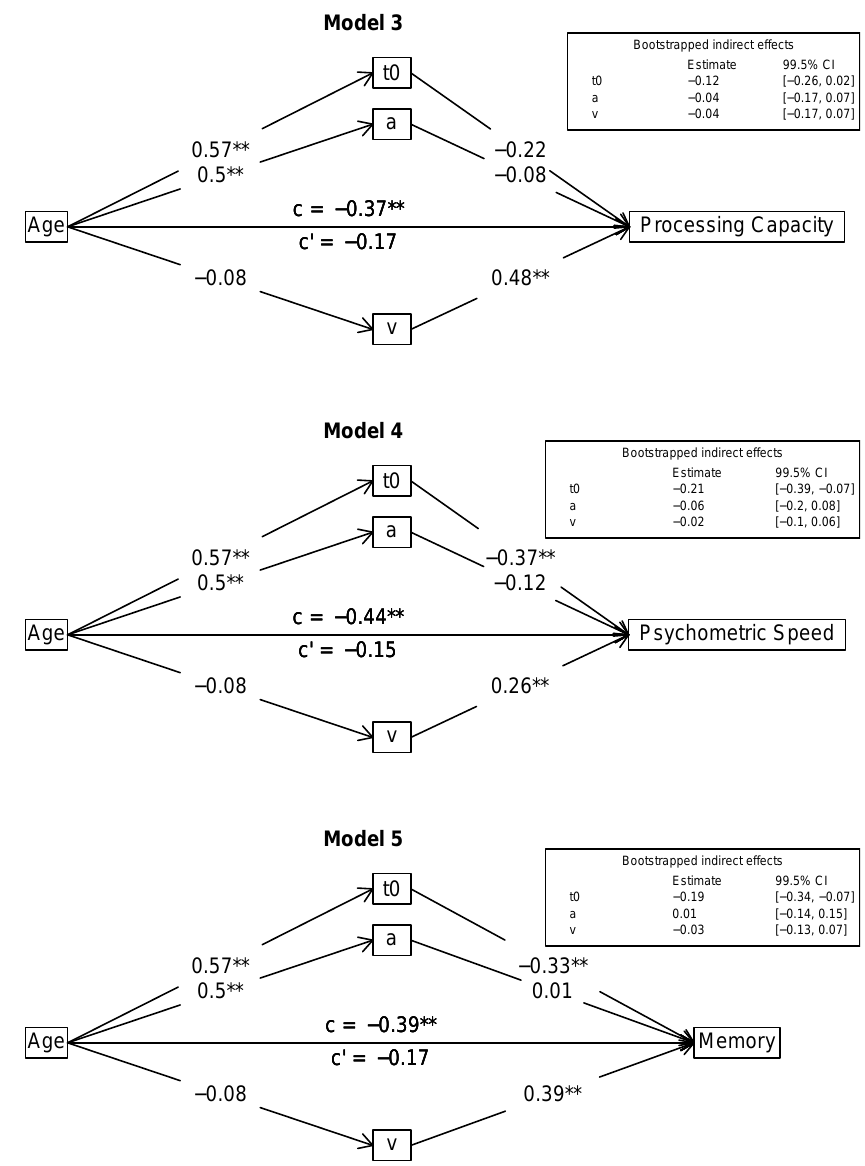
Figure 3. Mediation models for intelligence process domains. Standardized estimates are reported. ** p <